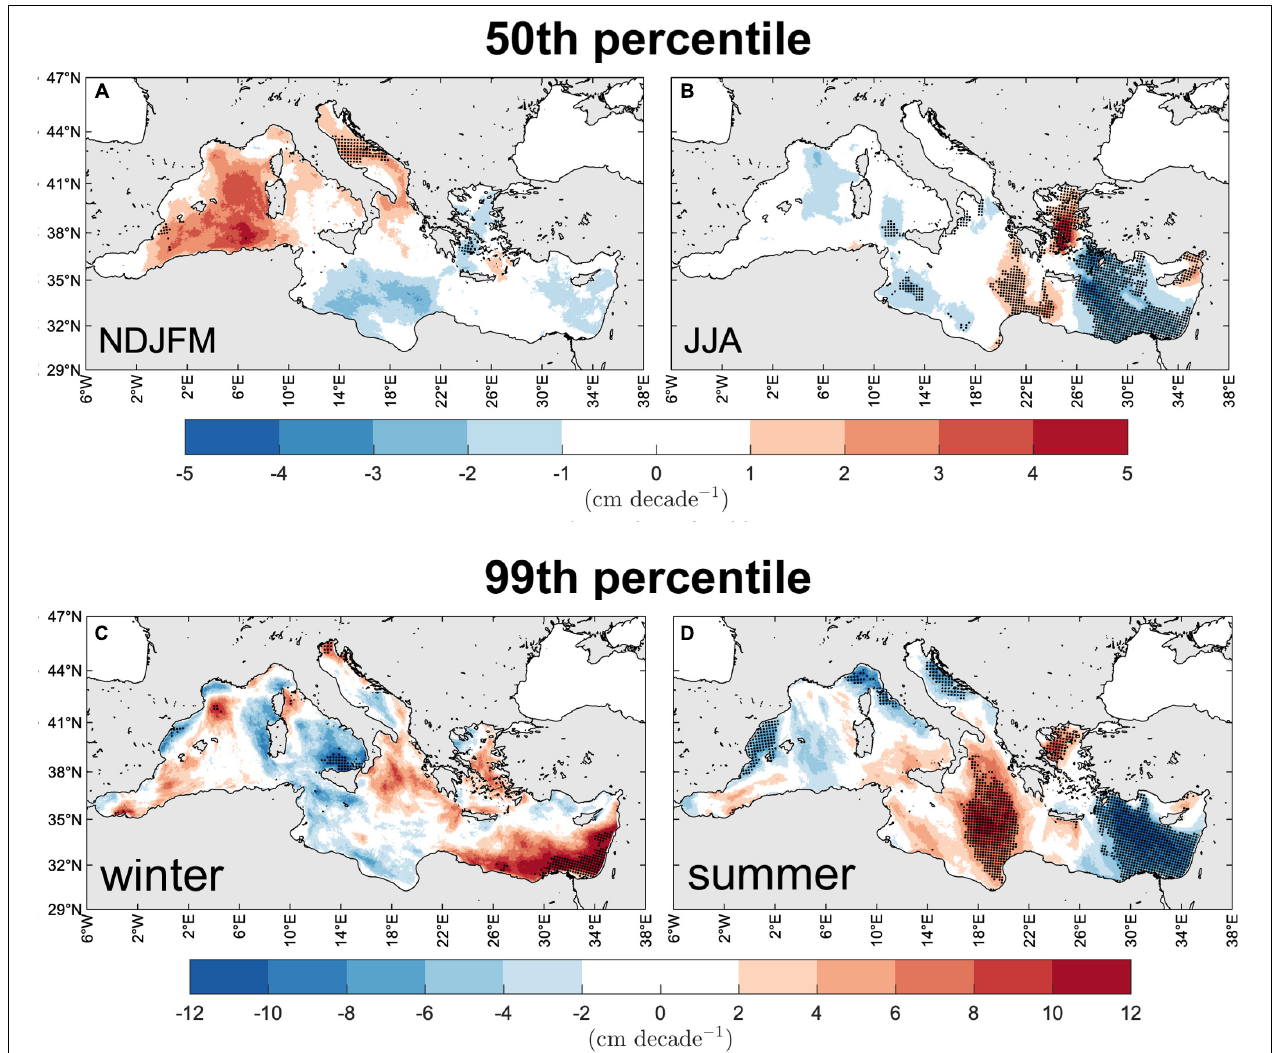
FIGURE 9 | Change of the MS typical [50th percentile, panels (A,B) ] and extreme [99th percentile, panels (C,D) ] wind-wave climate. Trend of winter [panels (A,C) ] and summer [panels (B,D) ] H s during 1981–2019. Area with statistically significant trends at the 90% confidence intervals are denoted by black dots (decimated for graphical purposes).